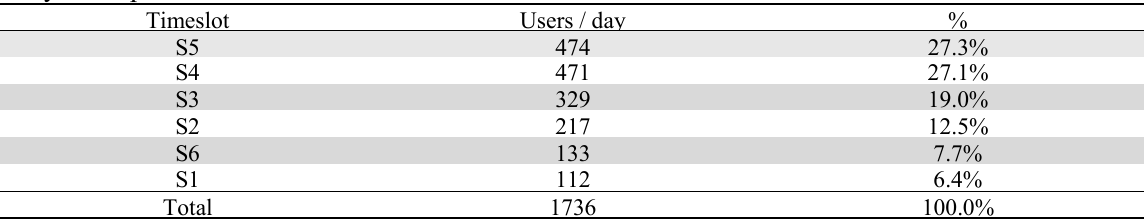
Daily users per